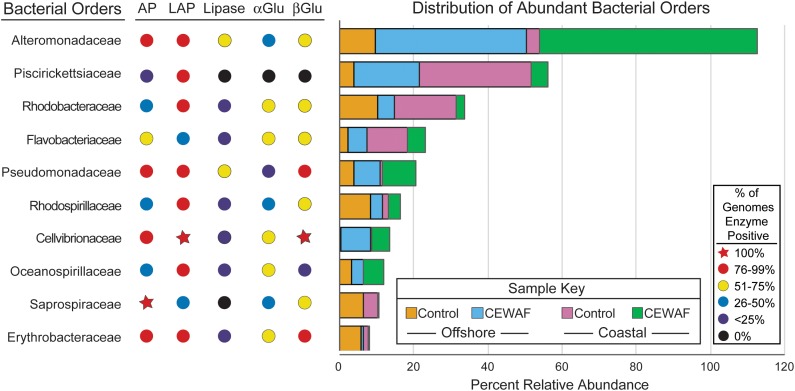
Distribution of bacterial orders with high relative abundance (defined as orders which are present at ≥1% relative abundance in two or more samples) and percentages of sequenced genomes containing exoenzymes assayed. The x-axis measures the relative abundance of taxa. AP, alkaline phosphatase; LAP, leucine aminopeptidase; αGlu, α-Glucosidase; βGlu, β-Glucosidase. The sequence of the genes coding for these enzymes were obtained from IMG database.